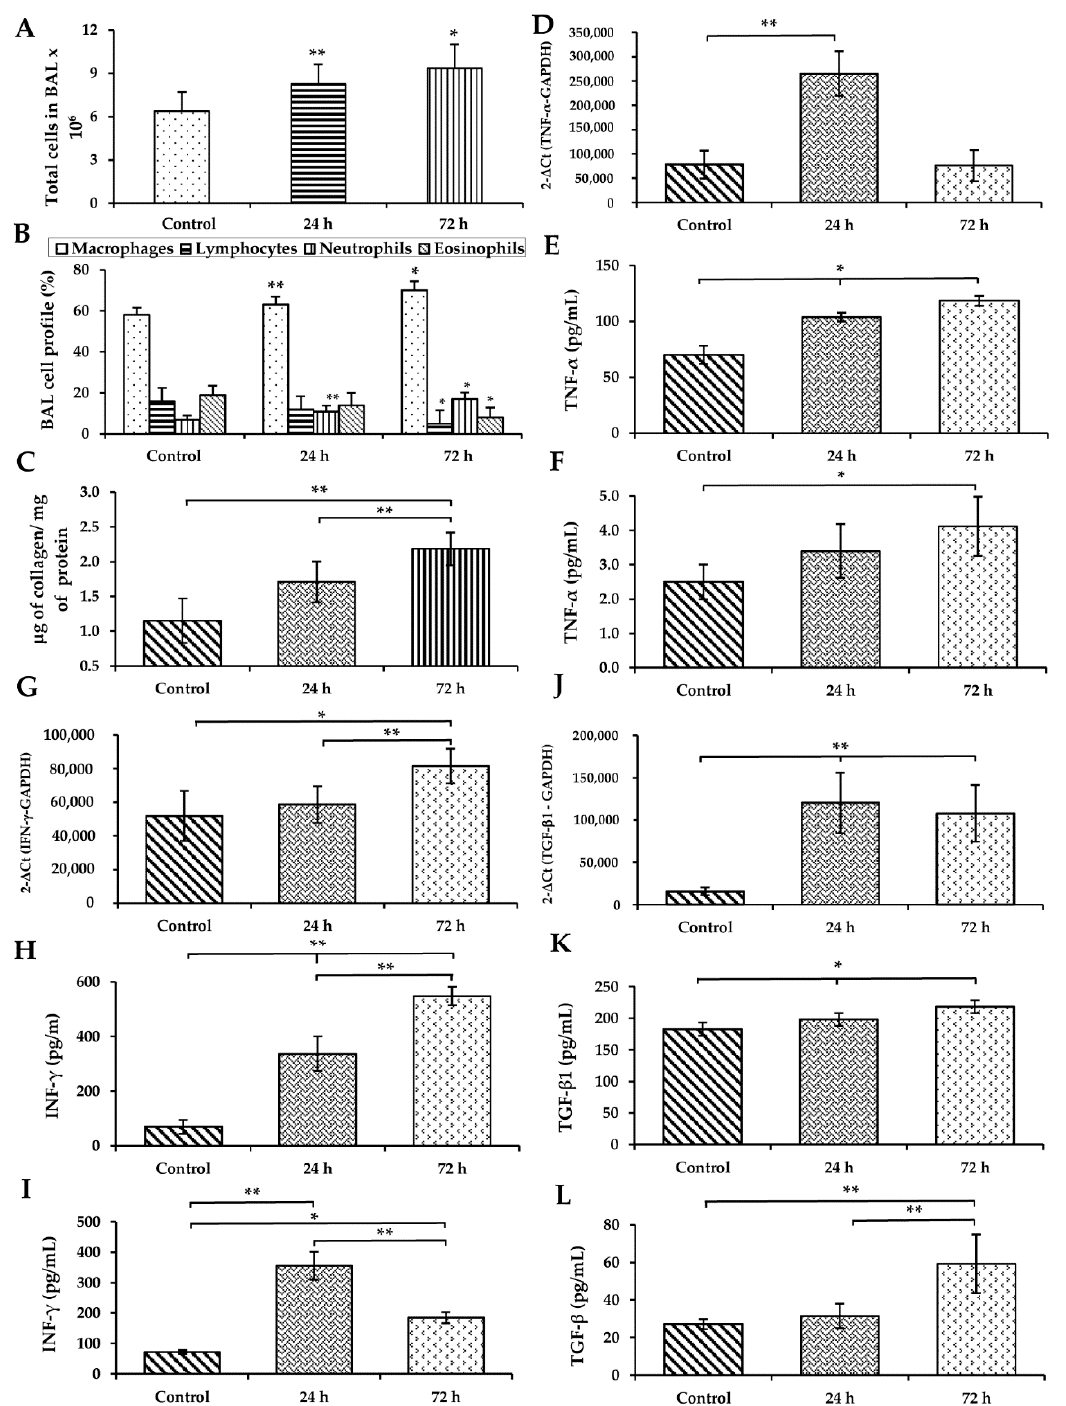
Figure 2. Effect of short-term exposure to WS on total cell number ( A ), differential cell count ( B ), and total soluble collagen ( C ) in BAL; mRNA expression levels of TNF- α ( D ), IFN- γ ( G ), and TGF- β 1 ( J ) in the lung; protein concentration of TNF- α in BAL ( E ) and serum ( F ), IFN- γ in BAL ( H ) and serum ( I ), and TGF- β 1 in BAL ( K ) and serum ( L ). Total cells and the number of macrophages, neutrophils, eosinophils, and lymphocytes were analyzed. Total collagen synthesis was measured with Sircol reagent in BAL fluid recovered from guinea pigs exposed to WS and filtered-ambient-air-exposed controls. qRT-PCR was used to detect the mRNA levels of expression, and ELISA was employed to detect the protein levels in BAL and serum ( n = 8). Statistical analyses were one-way analysis of variance (ANOVA), followed by Tukey–Kramer post hoc test. * p < 0.05; ** p < 0.01 compared with the control.